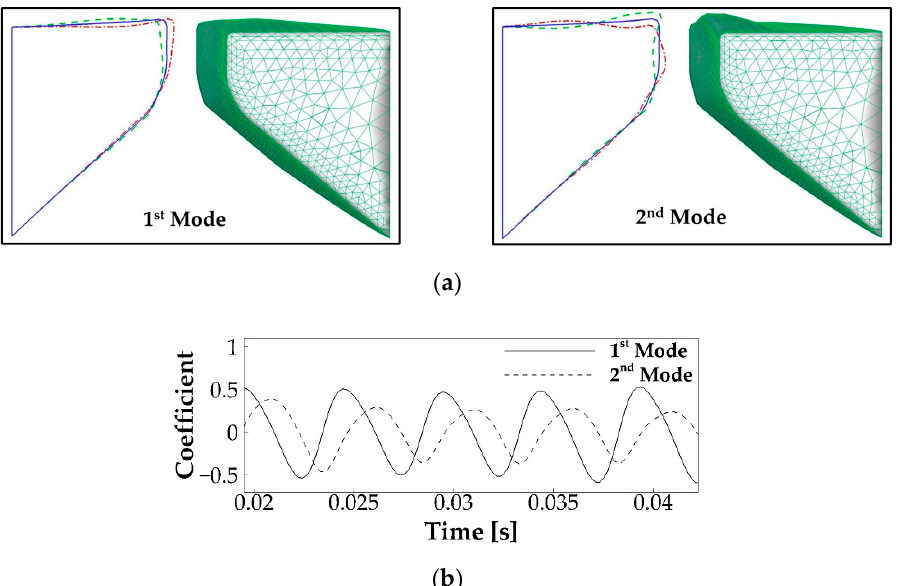
Figure 6. The proper orthogonal decomposition (POD) analysis of the vocal fold vibration in the baseline case. ( a ) The mid-coronal profile and three-dimensional shape of the first and second POD modes of the vocal fold vibration. In the 2D plot, the solid line illustrates the undeformed shape of the vocal fold, and the dashed and dashed-dot lines illustrate the two-extreme states of these two modes. ( b ) Time history of the modal coefficients of the two modes.